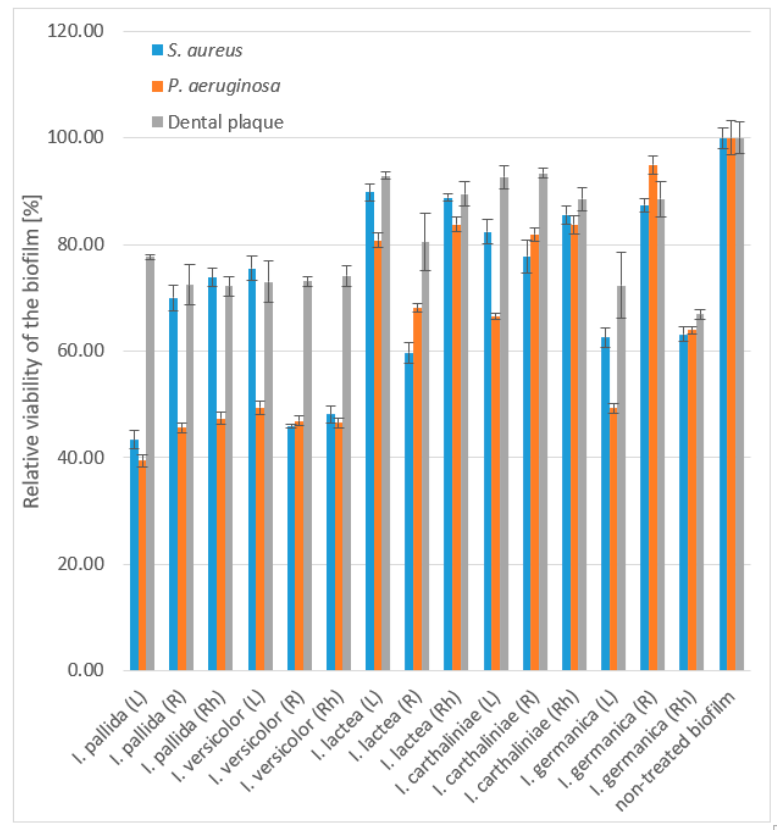
Figure 1. Disruption of mature biofilm by methanol extracts of Iris spp. at concentration of 666.7 mg/L. Data are presented as average of 3 repetitions with SEM. For the statistical analysis,